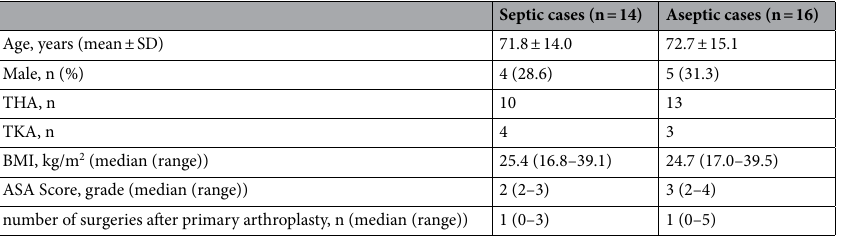
Table 1. Patient Demographics. THA Total Hip Arthroplasty; TKA Total Knee Arthroplasty; BMI Body Mass Index; ASA , American Society of